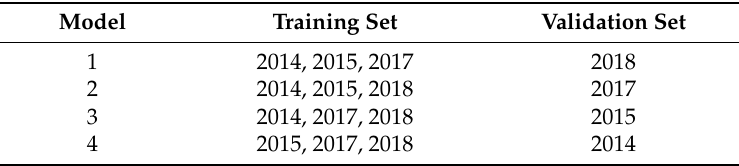
Table 2. Datasets used in the leave-out-one-year analysis.